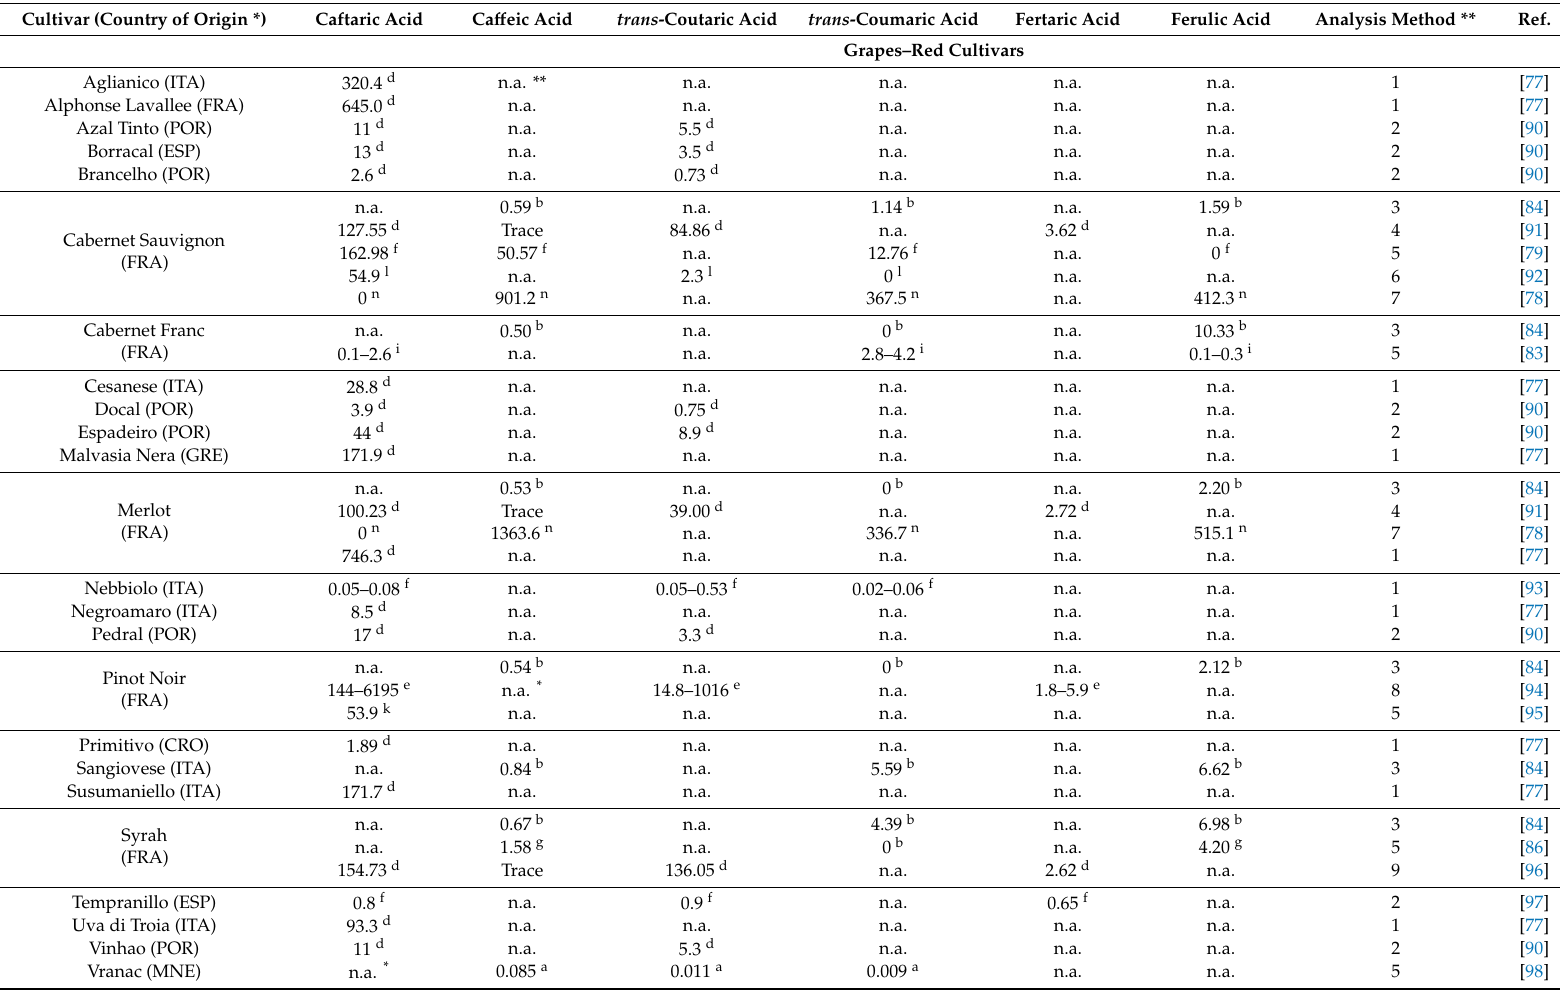
Table 2. Contents of hydroxycinnamic acids in the grapes and leaves of di ff erent grapevine